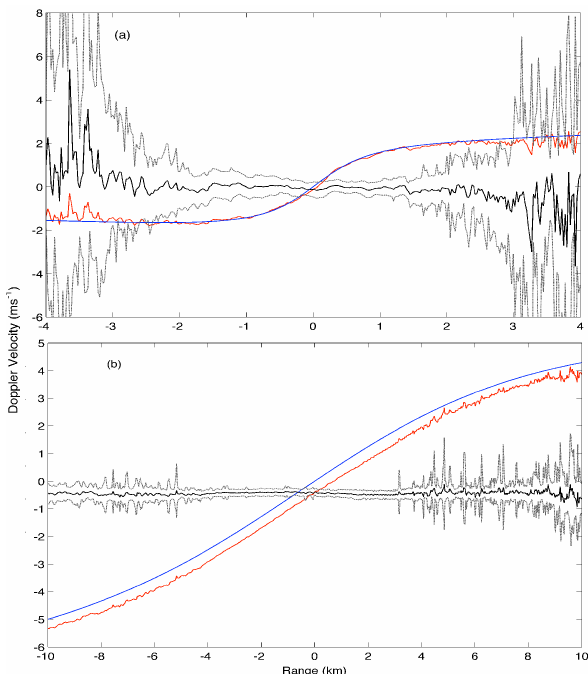
Fig. 12. Nineteen min averaged Doppler velocities at the middle of (a) a stratocumulus cloud layer and (b) a cirrus cloud case as a function of range from the radar. The 19min average implies that all 3-D gridded CW-RHI planes at this height have been used to estimate the mean and variance of the retrieved Doppler velocities. The radial observed Doppler velocities ( V D ,θ ) are shown in red, the fitted projected horizontal wind contributions ( V H , RHI cos (θ) ) are shown in blue and the retrieved vertical Doppler velocity ( V D , V ) in black. The standard deviation of the retrieved vertical Doppler velocity is in dashed